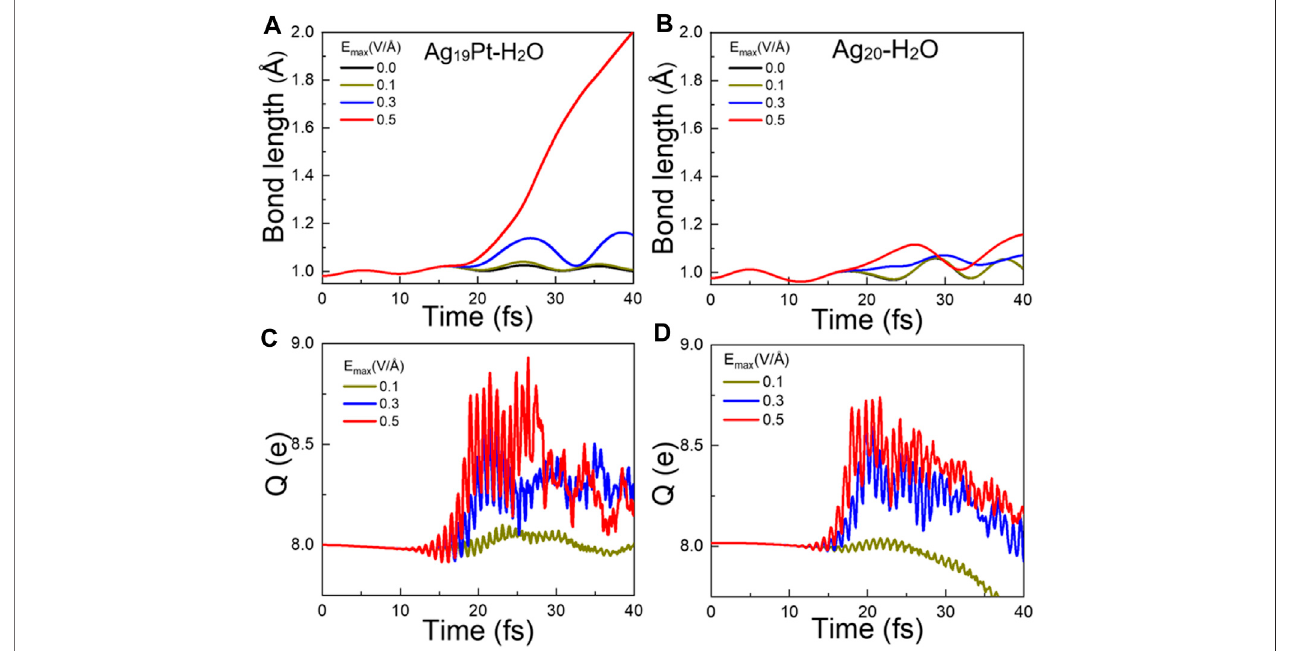
FIGURE 2 | Ultrafast dynamic responses after photoexcitation. Time evolved bond length of O – H for (A) Ag 19 Pt – H 2 O and (B) Ag 20 – H 2 O under different fi eld strengths E max . Time-evolved total charge (Q) located on H 2 O for (C) Ag 19 Pt – H 2 O and (D) Ag 20 – H 2 O under different fi eld strengths.